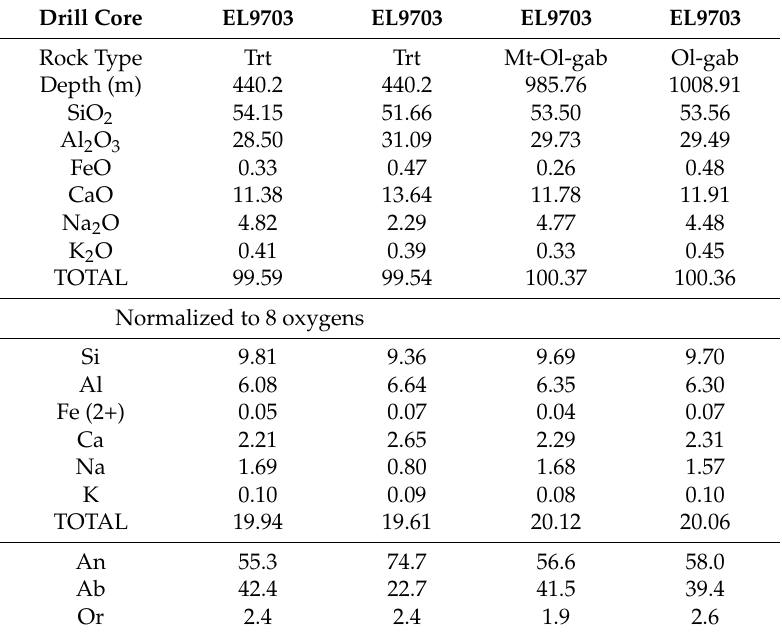
Table 4. Composition of plagioclase in the major rock